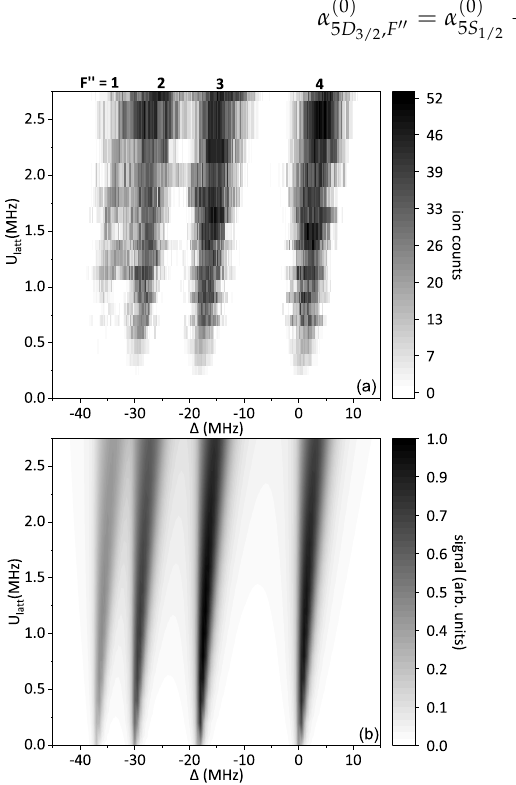
Figure 3. Experimental ion spectra ( a ) and corresponding results of numerical simulations ( b ) as a function of two-photon detuning, ∆ , and OL depth, U latt . Parameters used for ( b ) are ( 0 ) = − 499 a.u., α ( 2 ) = 0 a.u., and σ = 44 α 5 D 3/2 5 D 3/2